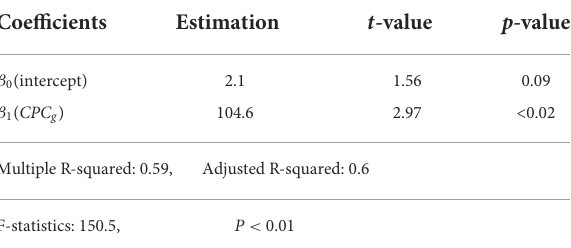
TABLE 3 Linear regression: C g ∼ β 0 + β 1 · b g